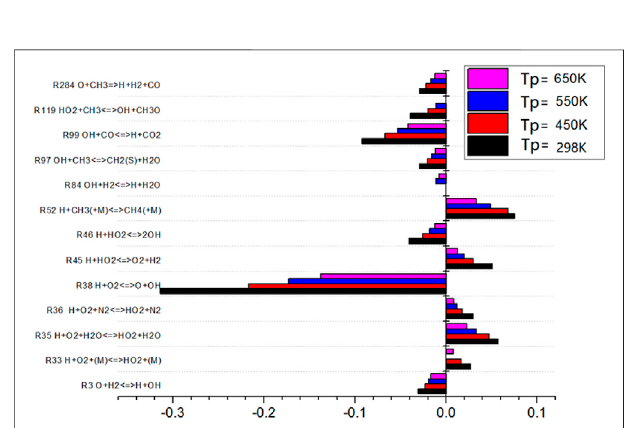
FIGURE 11 | Sensitivity of preheating temperature to combustion